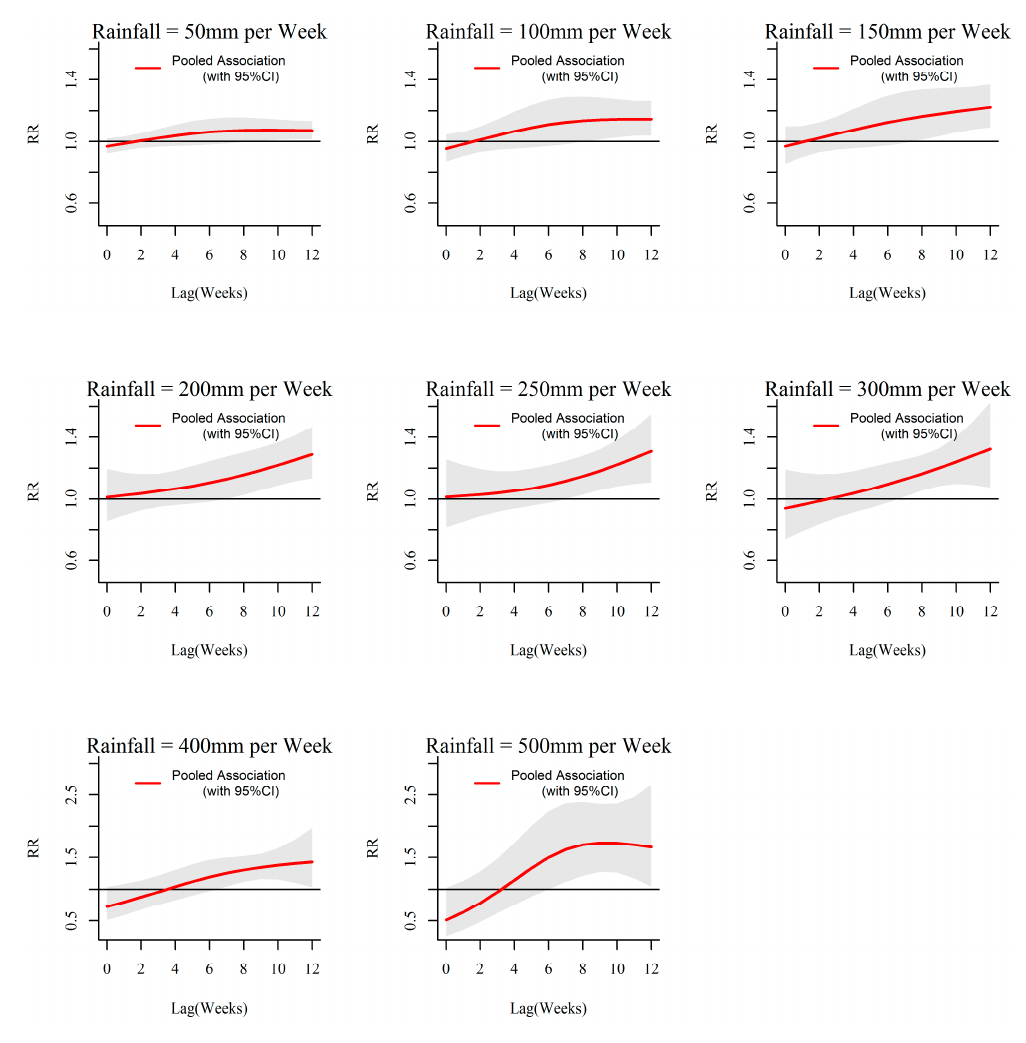
Figure 5. Relative risk (RR) by lag at specific cumulative rainfall levels predicted from the pooled exposure–response function for the 10 MOH divisions in Kalutara district, Sri Lanka, 2009–2013. The figure illustrates the predicted curves from meta-regression for different rainfall values of 50, 100, 150, 200, 250, 300, 400, and 500 mm per week. Shaded areas represent 95% confidence intervals. Reference at 0 mm per week.